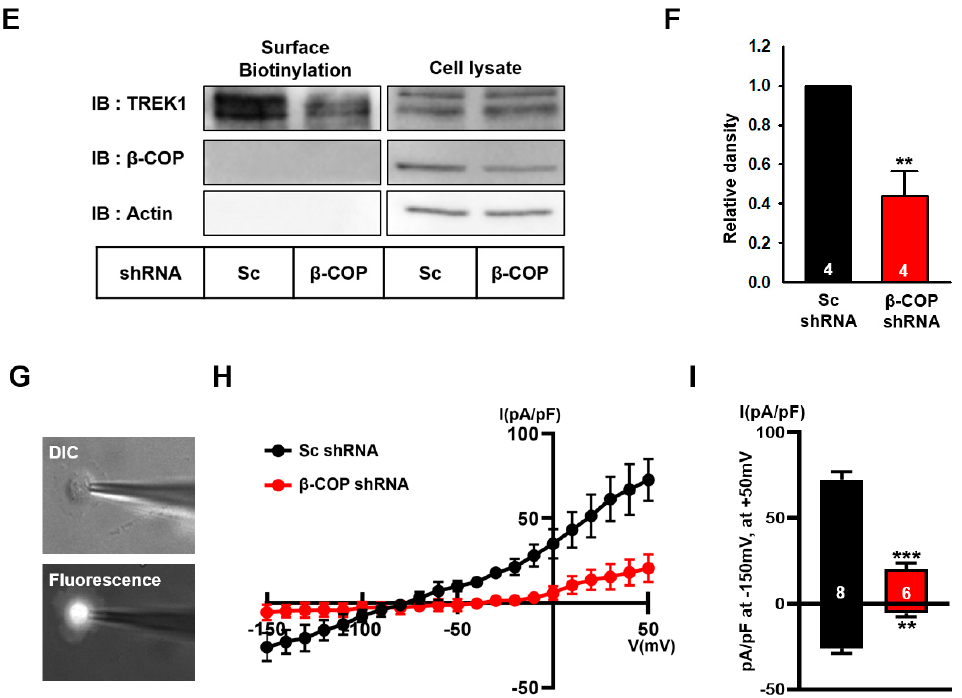
Figure 4. Silencing of β -COP decreases TREK1 trafficking in astrocytes. ( A ) Schematic diagram of the GFP- β COP, Sc-shRNA, and β -COP shRNA construct. The efficiency of β -COP shRNA was assessed by (down) fluorescent imaging. The shRNA constructs also express an mCherry signal. Scale bar, 100 µ m. ( B ) Efficiency of gene silencing by the β -COP shRNA construct was monitored by Western blot. ( C ) Representative immunocytochemistry images stained with the anti-TREK1 antibody in cultured astrocytes transfected with Sc-shRNA or β -COP shRNA. Wheat germ agglutinin (WGA) was used to stain the plasma membrane of astrocytes. Scale bar, 20 µ m. ( D ) Pearson’s correlation coefficient for TREK-1 and WGA. ( E ) Cell surface biotinylation assay in Sc shRNA and β -COP shRNA transfected astrocytes. Surface expression of TREK1 was slightly decreased by β - COP shRNA expression. ( F ) Relative density of the cell surface expression. ( G ) DIC(differential interference contrast) (upper) and fluorescence (lower) image of cultured astrocyte transfected with β -COP shRNA. The β -COP shRNA construct also expresses an mCherry signal. ( H ) Average I - V relationship of Sc shRNA (black) and β -COP shRNA (red) transfected astrocytes. The voltage ramp- induced whole-cell current traces were recorded from each cell. ( I ) Summary bar graph plotted from the results in (H) at +50 mV. All values in ( D ), ( F ), and ( I ) are expressed as the mean ± SEM. SEM, standard error of the mean. p -values were obtained with Student’s t -test. ** p < 0.01, *** p <